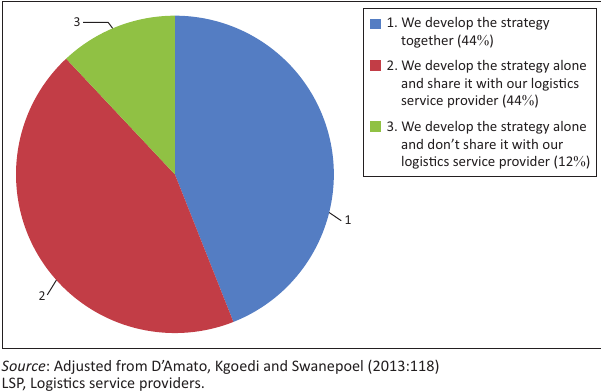
FIGURE 4: Strategy development – inclusion of logistics company